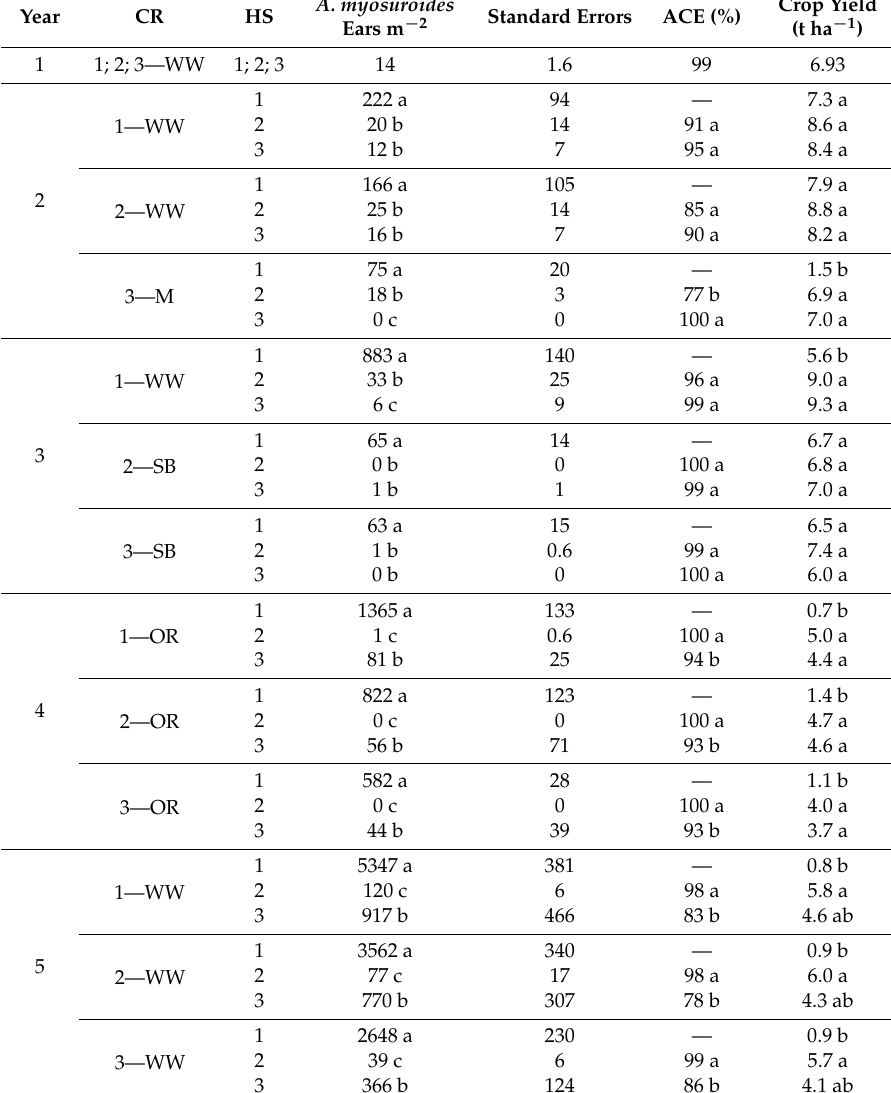
Table 3. Average densities of A. myosuroides ears m − 2 , A. myosuroides control efficacy (ACE) and crop yield in the crop rotations (CR) and herbicide strategies